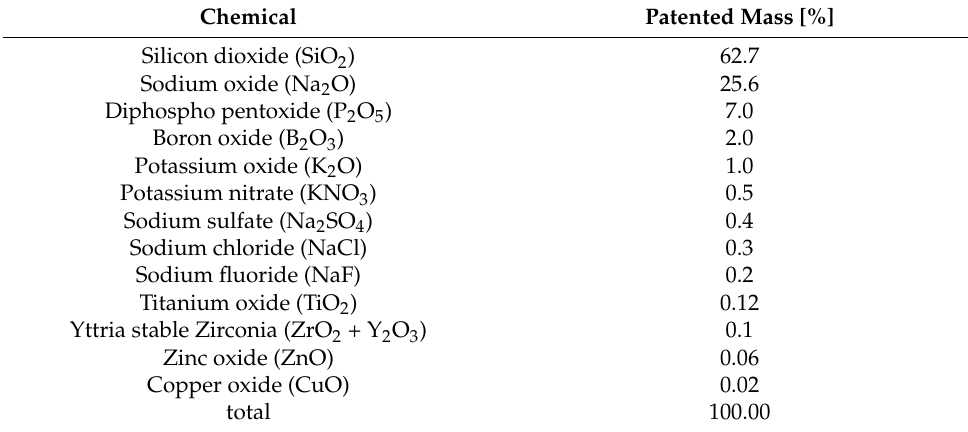
Table 1. chemical composition of